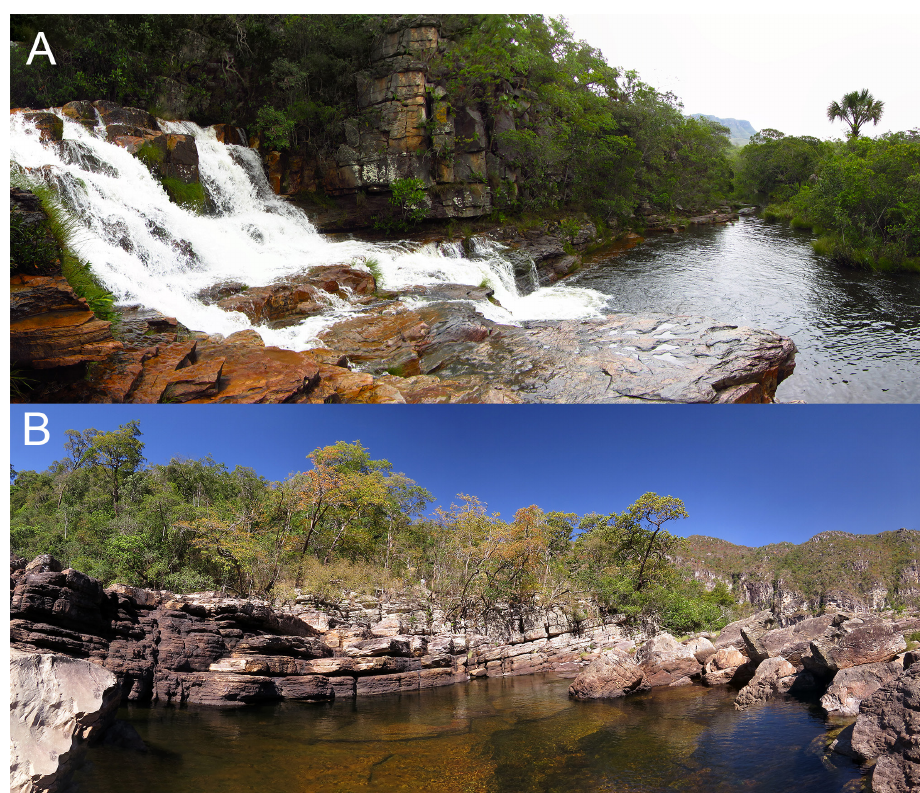
FIGURE 8 | Habitats of Characidium kalunga at the Chapada dos Veadeiros: A . Type locality, cachoeira das Almécegas II, at rio Almécegas, tributary of rio dos Couros; B . Rio Preto, at Parque Nacional da Chapada dos